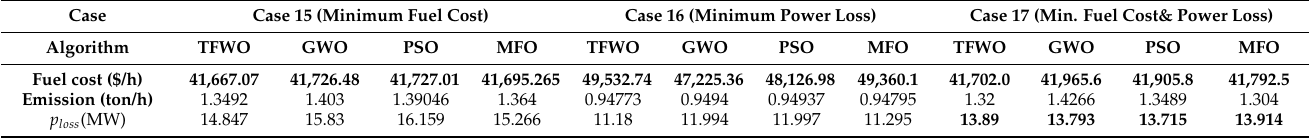
Table 8. TFWO versus recent optimization algorithms (IEEE-57 bus test system) for Cases 15–17.